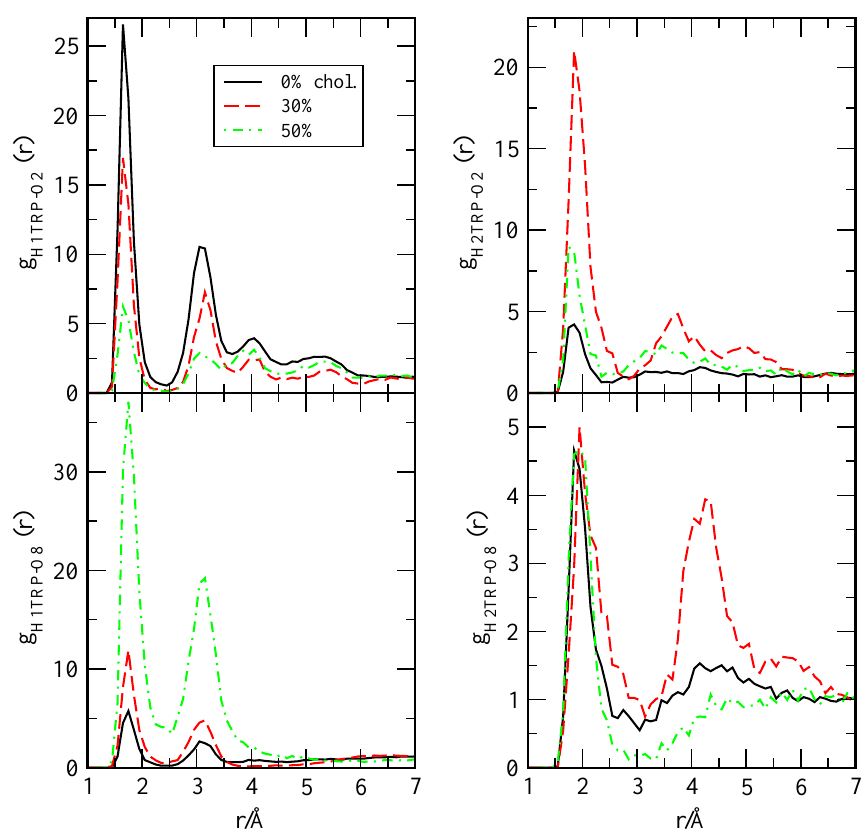
Figure 4. Radial distribution functions for TRP with DPPC (charged sites ‘H1’, ‘H2’, ‘O2’, and ‘O8’, see Figure 1): H1TRP-O2 ( top left ), H1TRP-O8 ( bottom left ), H2TRP-O2 ( top right ), and H2TRP-O8 ( bottom right ). Data are partially taken from Ref. [107].